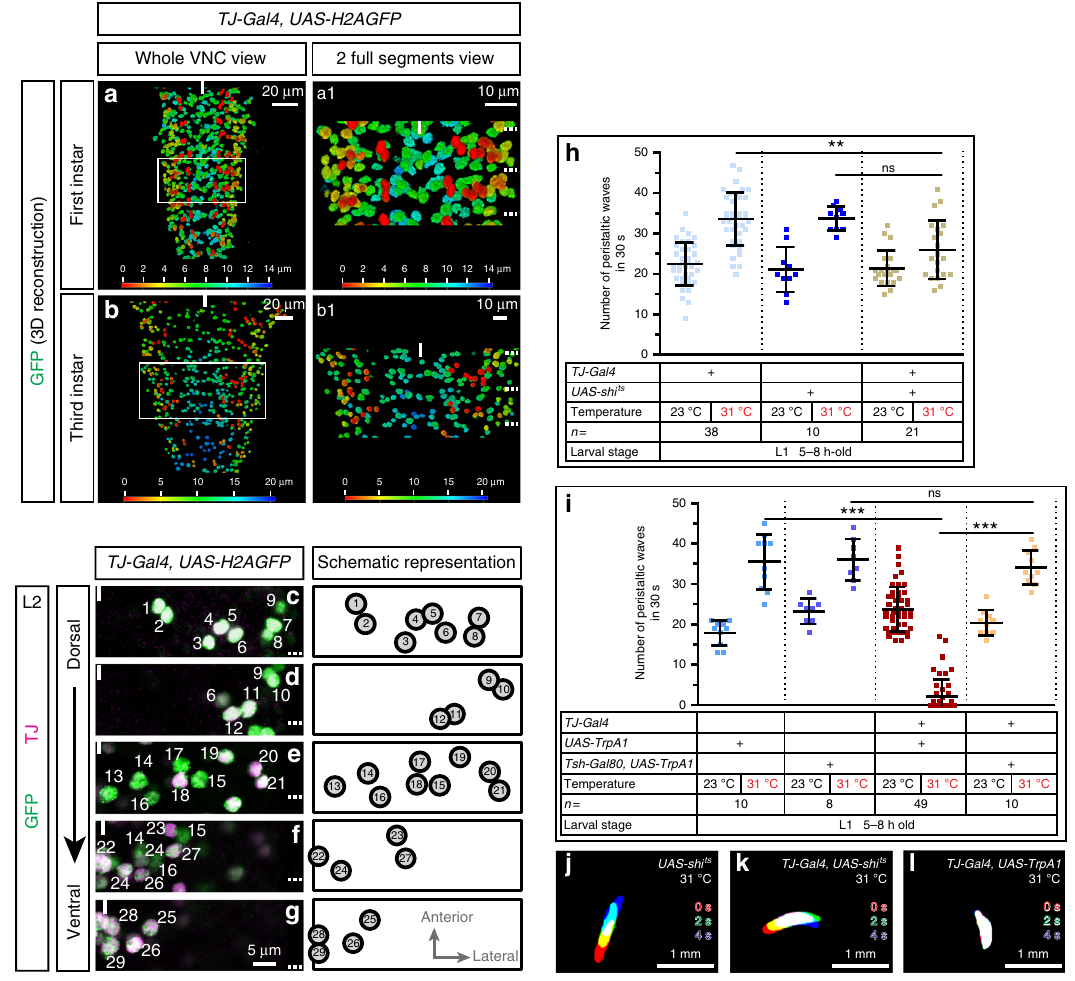
Fig. 1 TJ + neurons are required for proper larval crawling. a , b 3D reconstruction of whole VNC of fi rst ( a ) and third ( b ) instar larvae expressing nuclear GFP under the control TJ-Gal4 . Color scale is the z -axis scale; most dorsal cells are red, and most ventral are blue. White scale is the x / y -axis scale. c – g Staining of a second instar larva VNC for TJ (magenta) and TJ-Gal4 expression reported by nuclear H2AGFP (green). Totality of TJ-expressing cells are shown in dorsal ( c ) to ventral ( g ) panels. Dashed lines on the right-hand side of the panels indicate segment boundaries and the full line the midline. A unique hemisegment is shown in each panel. Anterior of the VNC is up. Right panels are schematic representations of one hemisegment showing stereotyped ventral – dorsal and medial – lateral cell position of TJ-expressing cells. h , i Number of peristaltic waves per 30 s at (23 °C) and (31 °C). Note that larvae naturally increase the numbers of peristaltic waves at 31 °C compared to 23 °C. Silencing of the entire TJ + population (second beige dot plot, h ) causes a slight decrease in the number of peristaltic waves. Activation of the entire TJ + population (second red dot plot) causes a drastic decrease in the number of peristaltic waves ( i ). This decrease is no longer visible upon activation of the TJ + neurons exclusively in the brain (second salmon pink dot plot, i ). For h and i , each single point represents recording of a single fi rst instar larva. Error bars indicate the mean ± SD and n the number of larvae tested. Statistical analysis: Graph i : one-way ANOVA. *** p ≤ 0.001, ns = not signi fi cantly different. Graph h : Kruskall – Wallis. ** p ≤ 0.01, ns = not signi fi cant. j – l Superimposition of three consecutive time frames (0, 2, and 4 s) showing the postures of 5-h-old larvae: control larvae ( j ), upon silencing of the TJ + neuronal population ( k ) and upon activation of the TJ + population ( l TJ-Flp in “ fl ip-out ” experiments using Act>Stop>Gal4::UAS-CD8-